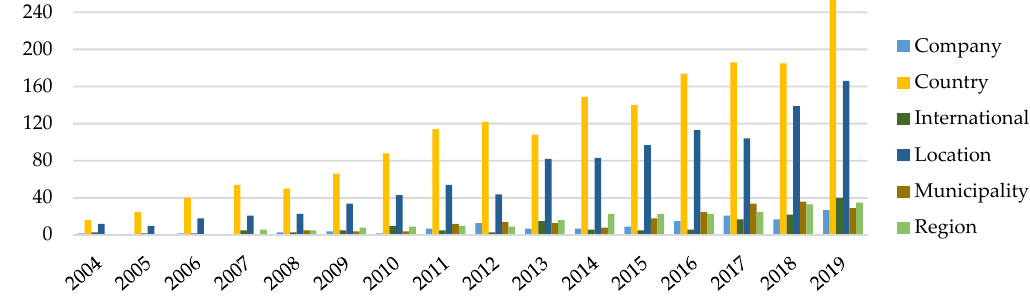
Figure 9. Level of governance. Source: Authors; N = 3534.